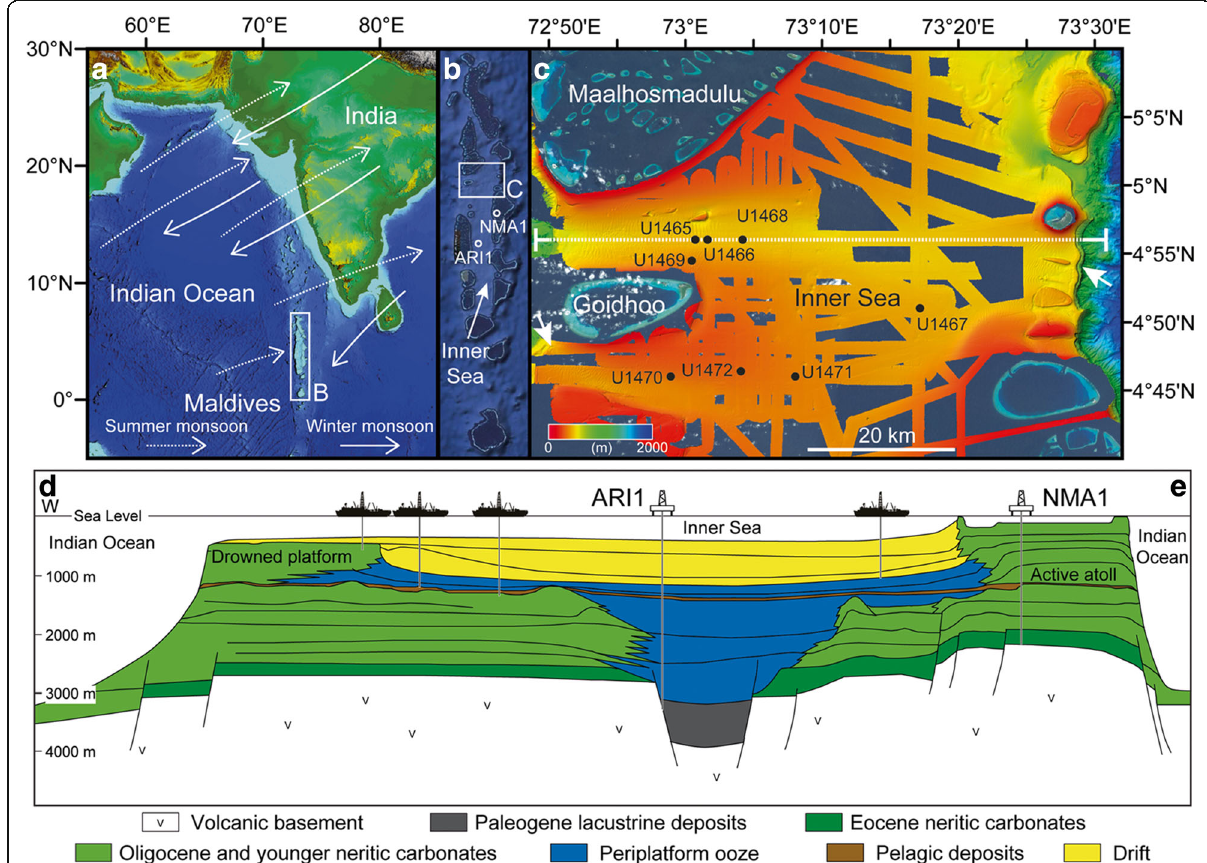
Fig. 1 a , b Location of the Maldives archipelago in the Indian Ocean. The rectangles labeled B and C in ( a ) and ( b ) outline the detailed views shown in ( b ) and ( c ), respectively. c Merged multibeam imagery and satellite photography of the atolls in the area studied (from Betzler et al. 2016a). Stippled white line indicates position of seismic cross section shown in ( d ). Satellite imagery and seafloor imagery from www.worldwind.arc.nasa.gov and www.geomapapp.org. d Schematic cross section through the Maldives carbonate edifice with projected location of industry wells ARI1 and NMA1 as well as the locations of IODP sites. These were strategically positioned to core the most relevant intervals of the Neogene carbonate platform succession. The drift facies encompass all current-controlled sediments of the Maldives carbonate platform (sheeted drifts and drift fans, submarine